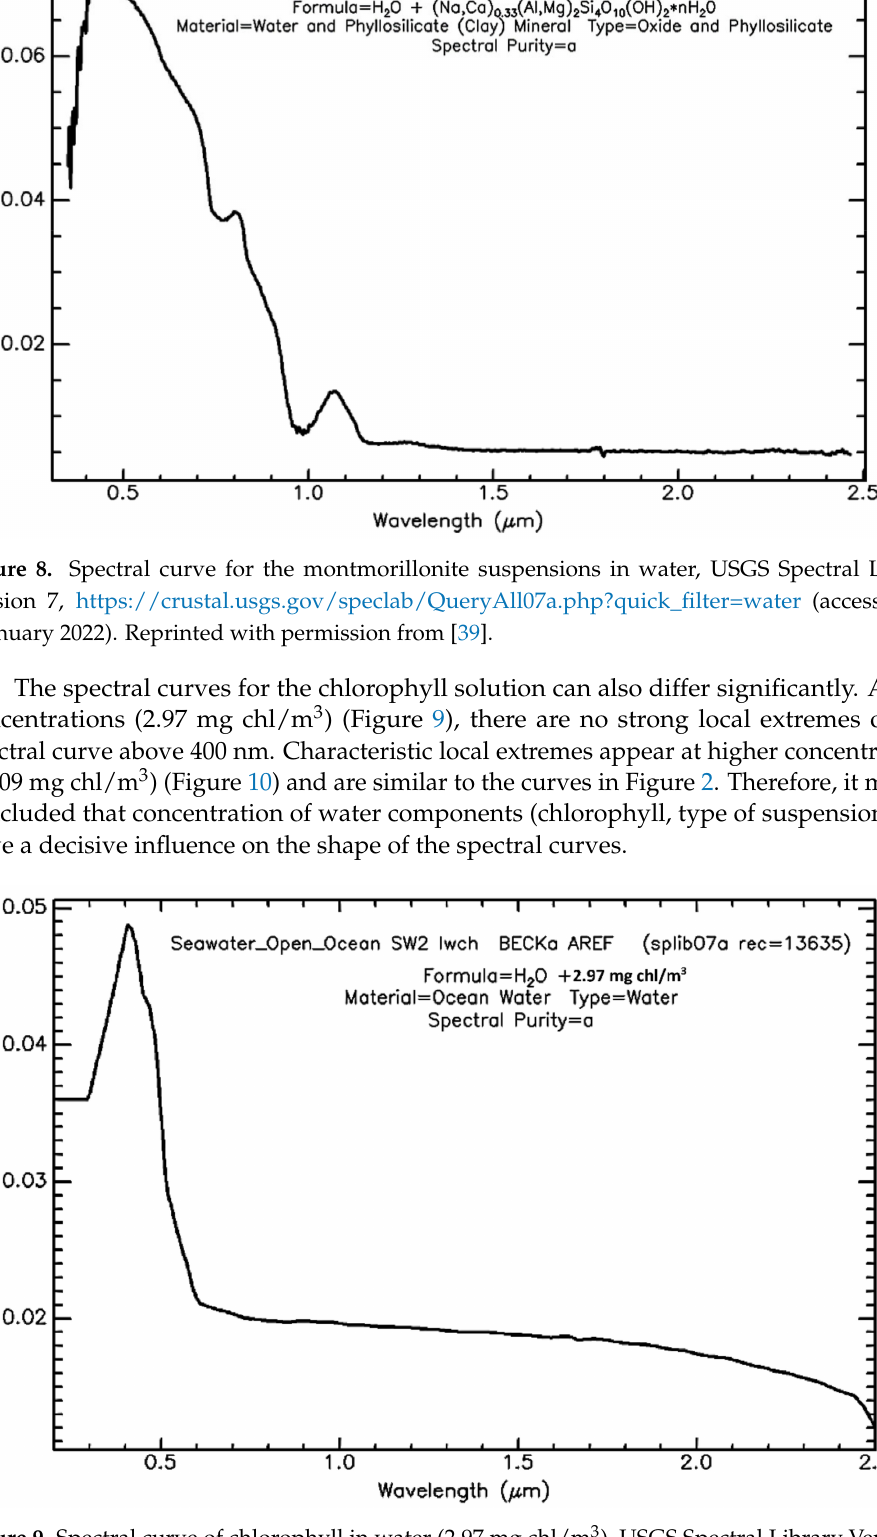
Figure 9. Spectral curve of chlorophyll in water (2.97 mg chl/m 3 ), USGS Spectral Library Version 7, https://crustal.usgs.gov/speclab/QueryAll07a.php?quick_filter=water (accessed on 1 January 2022). Reprinted with permission from